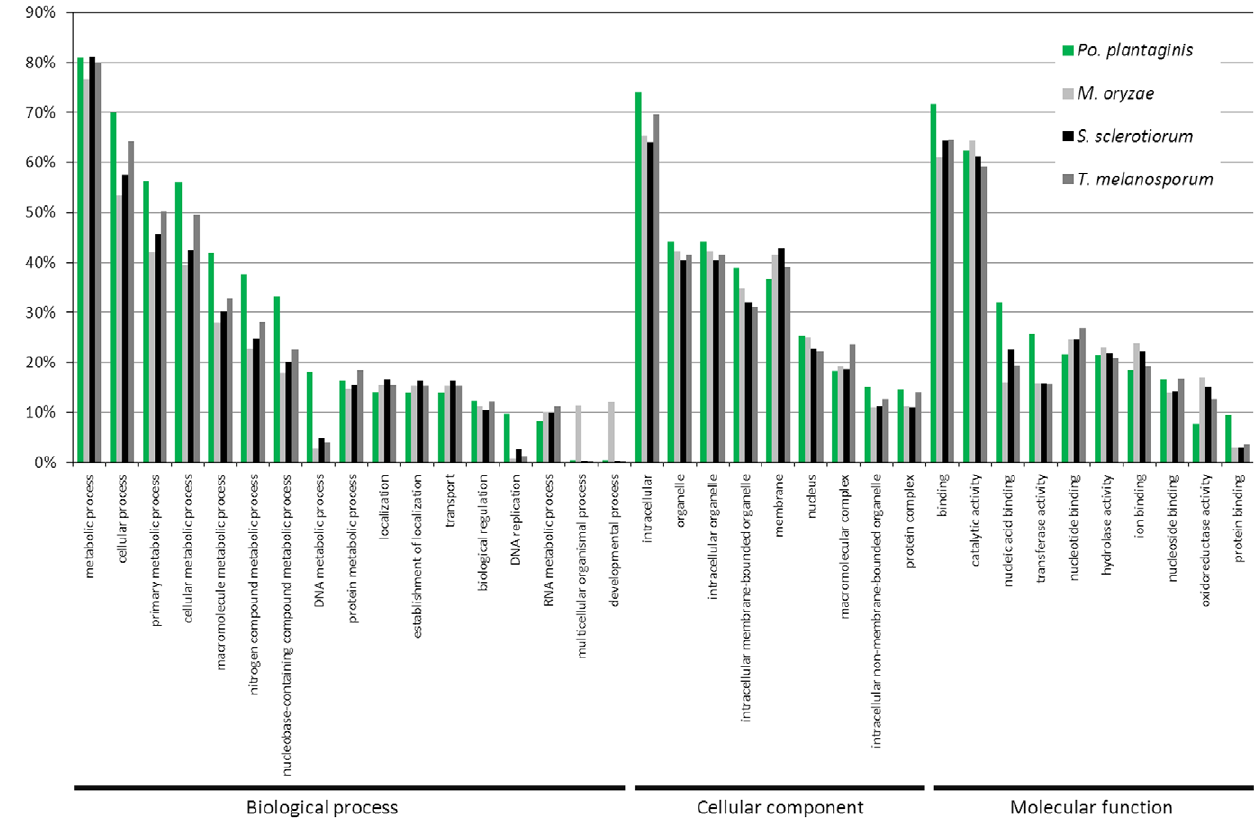
Figure 2. Frequency of the Gene Ontology (GO) terms found in transcriptome sequences of Podosphaeraplantaginis , compared to the genomic data of three other fungal species: Magnaporthaeoryzae , Sclerotiniasclerotiorum and Tubermelanosporum .